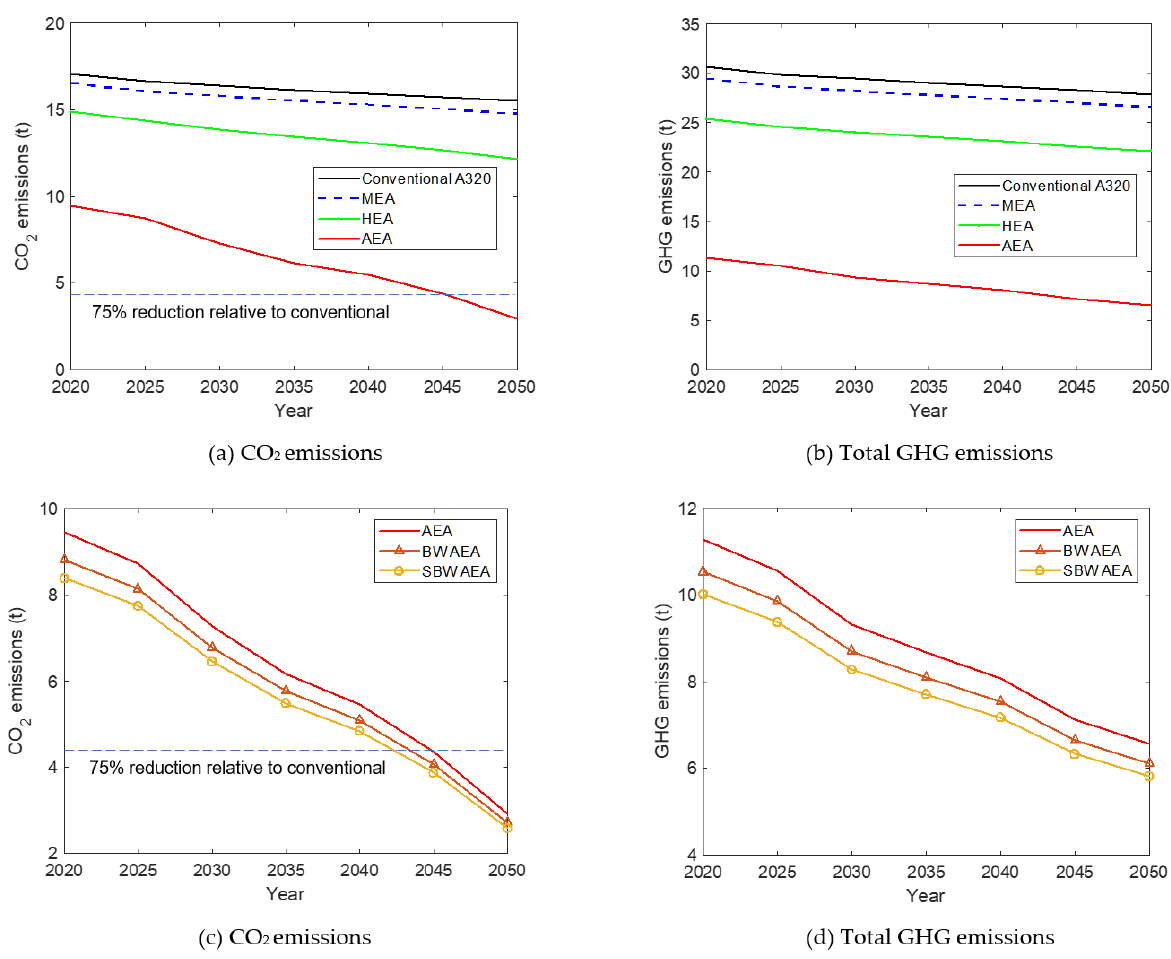
Figure 14. A320 emissions with various SPC airframe configurations over a 1500 km mission ( a , b ) with conventional wings and ( c , d ) the effect of slender wings.